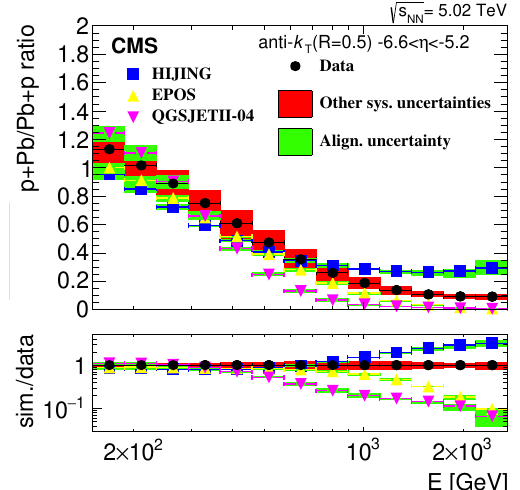
Figure 3 . Detector-level ratio of di(cid:11)erential cross sections for inclusive forward jet production in p+Pb to Pb+p data vs. calibrated jet energy. Model predictions are shown for epos-lhc , hijing , and qgsjetii-04